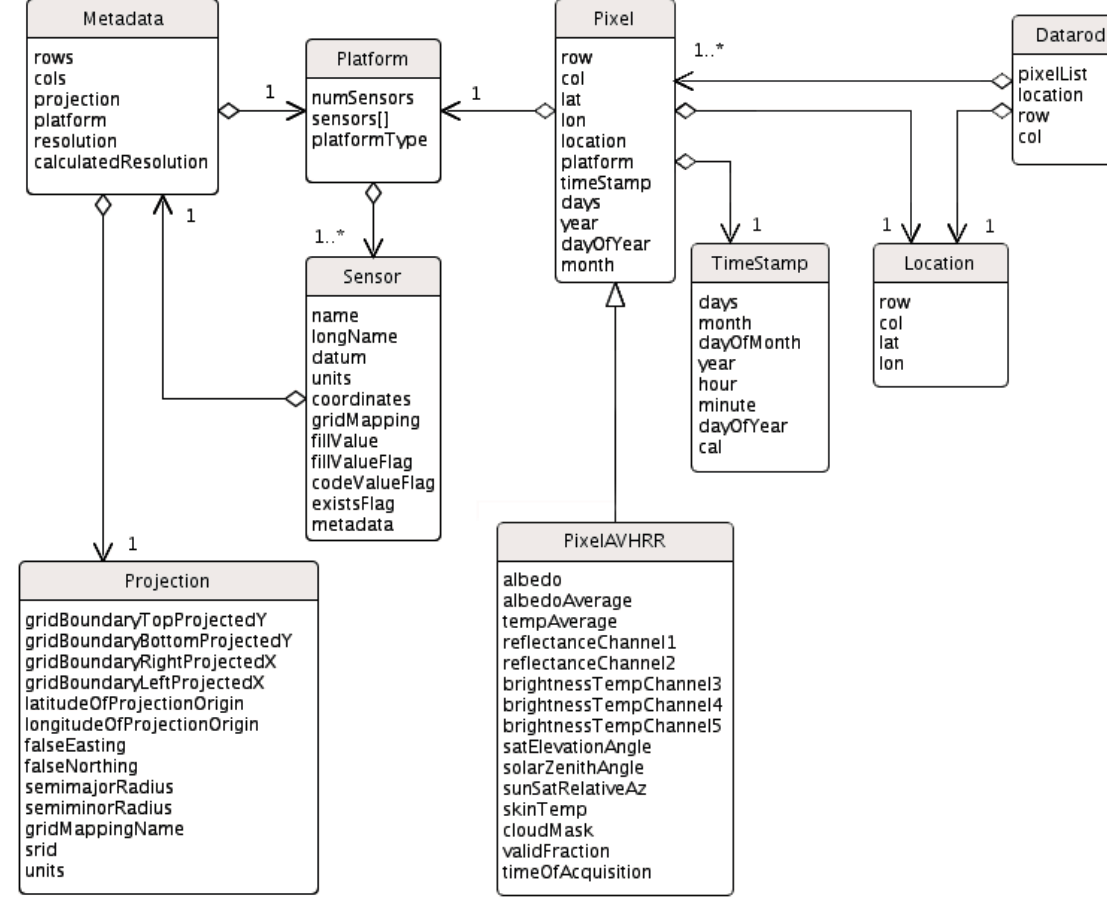
Figure 2. A Unified Modeling Language (UML) block diagram of the object-oriented schema for the databases and programming